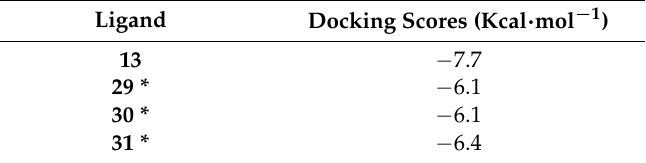
Table 2. Docking scores (Kcal · mol − 1 ) of compound 13 and known procaspase activators 29 – 31 using procaspase-7 as target.